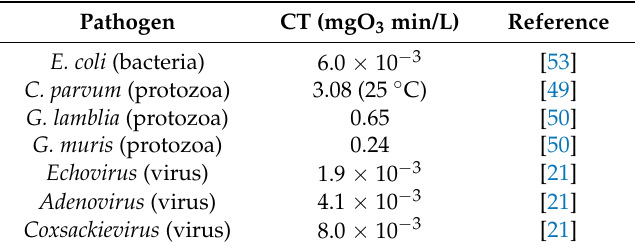
Table 2. CT values required by ozonation for 2 log inactivation of selected pathogens from